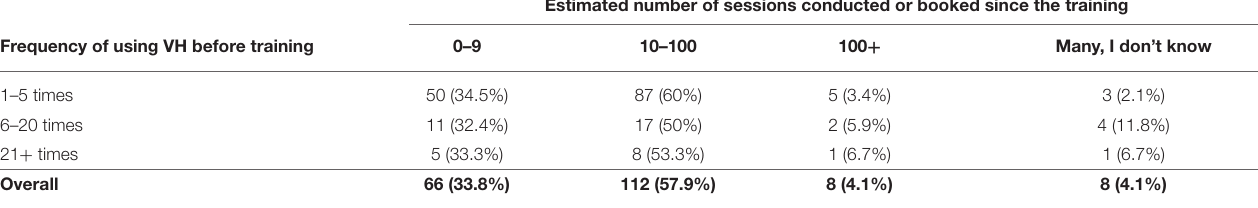
TABLE 2 | Estimated number of sessions booked or conducted in the weeks following the training.